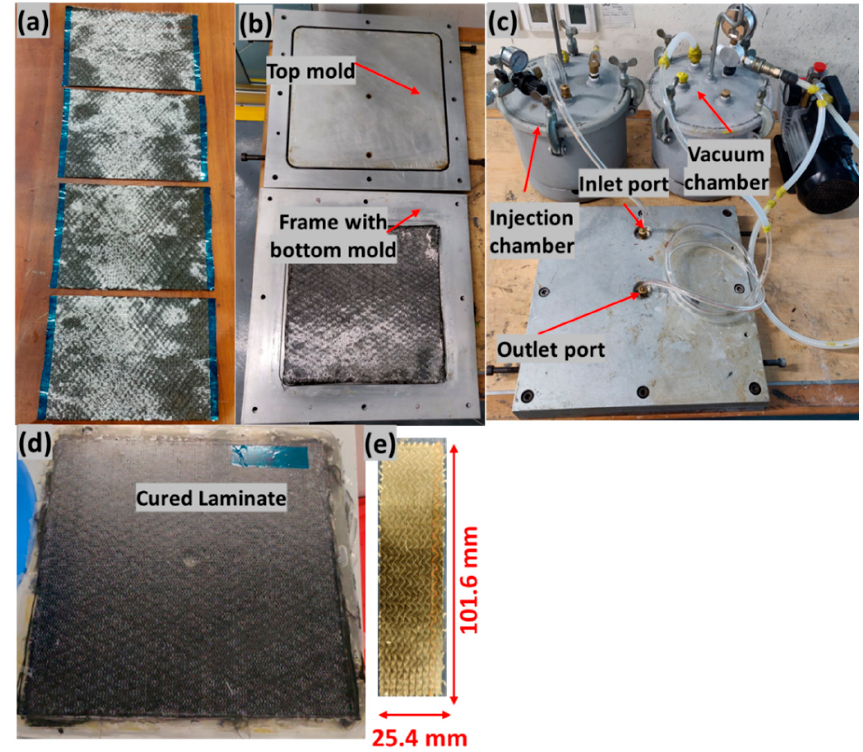
Figure 2. ( a ) Cut dry carbon fiber, ( b ) fiber in mold, ( c ) RTM setup, ( d ) cured laminate, ( e ) sample cut out from laminate.